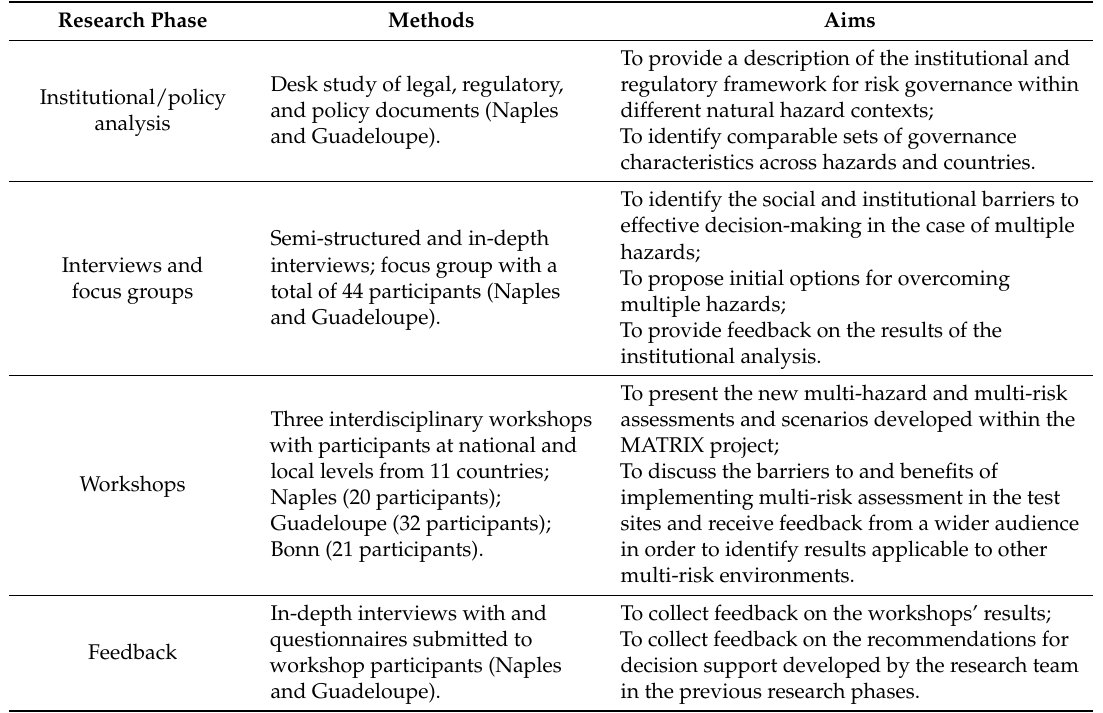
Table 2. Research phases